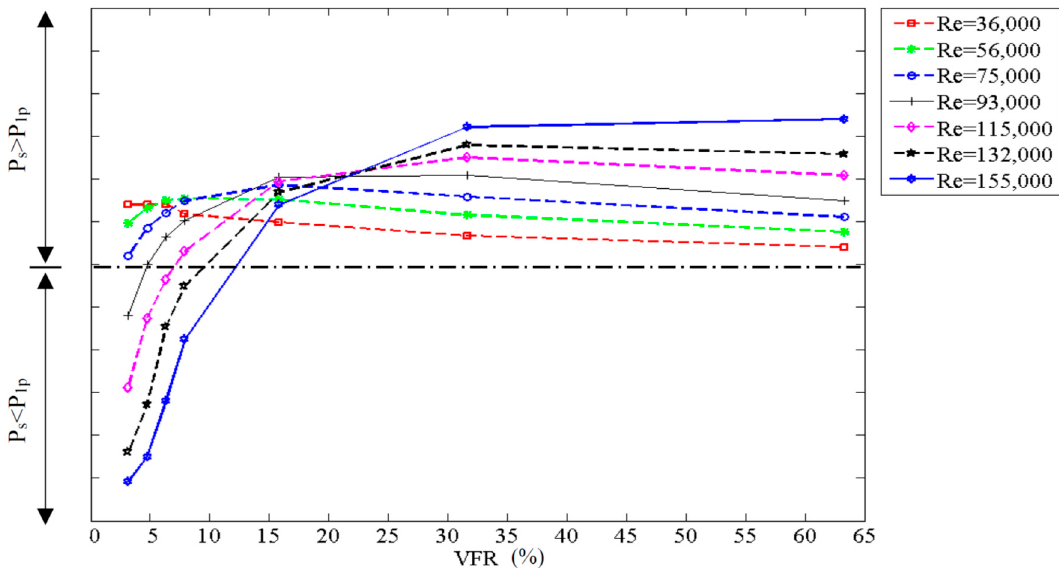
Figure 3. Comparison of the final stored pressure (P s ) with the first peak (P 1p ).